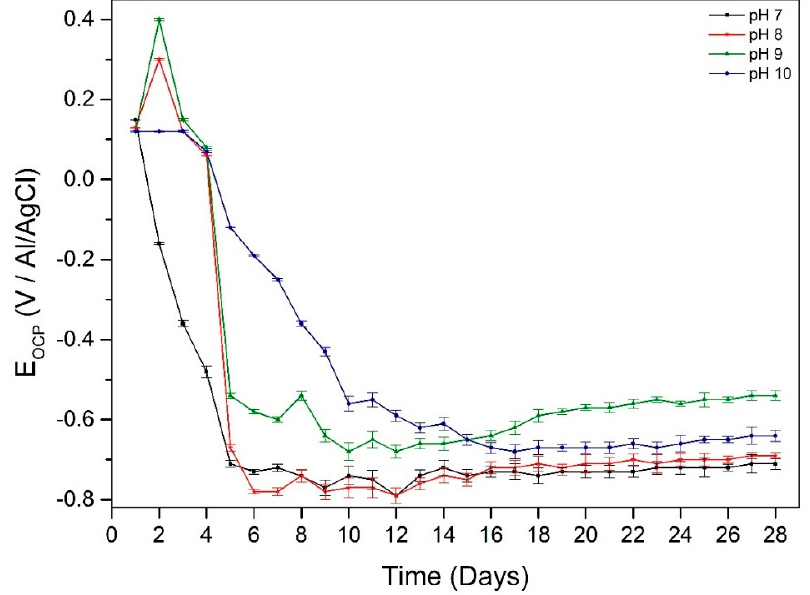
Figure 5. OCP curves of DSS 2205 in pH 7, 8, 9 and 10 environments over time for samples at different starting pH.